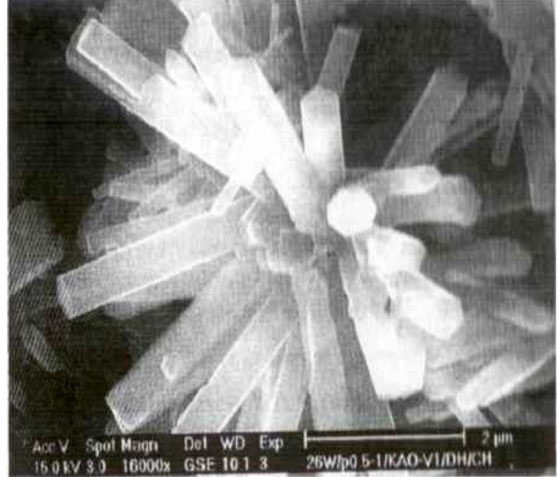
Figure 3. Crystals of ettringite with hexagonal prismatic morphology.